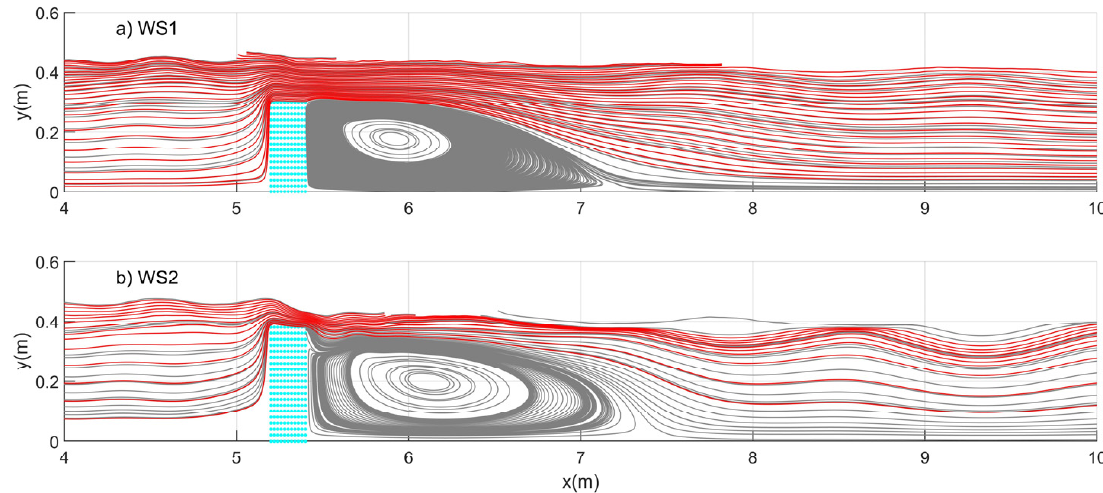
Figure 4. Streamlines for ( a ) WS1 and ( b ) WS2. The gray lines indicate streamlines that pass through the points, with 0.025 m spacings at vertical lines at x = 5.46 (just beside the structure), 6 (center of the recirculation zone), and 7.7 m (end of the recirculation zone). The red lines indicate streamlines that pass through the points at the passage above the submerged structure.